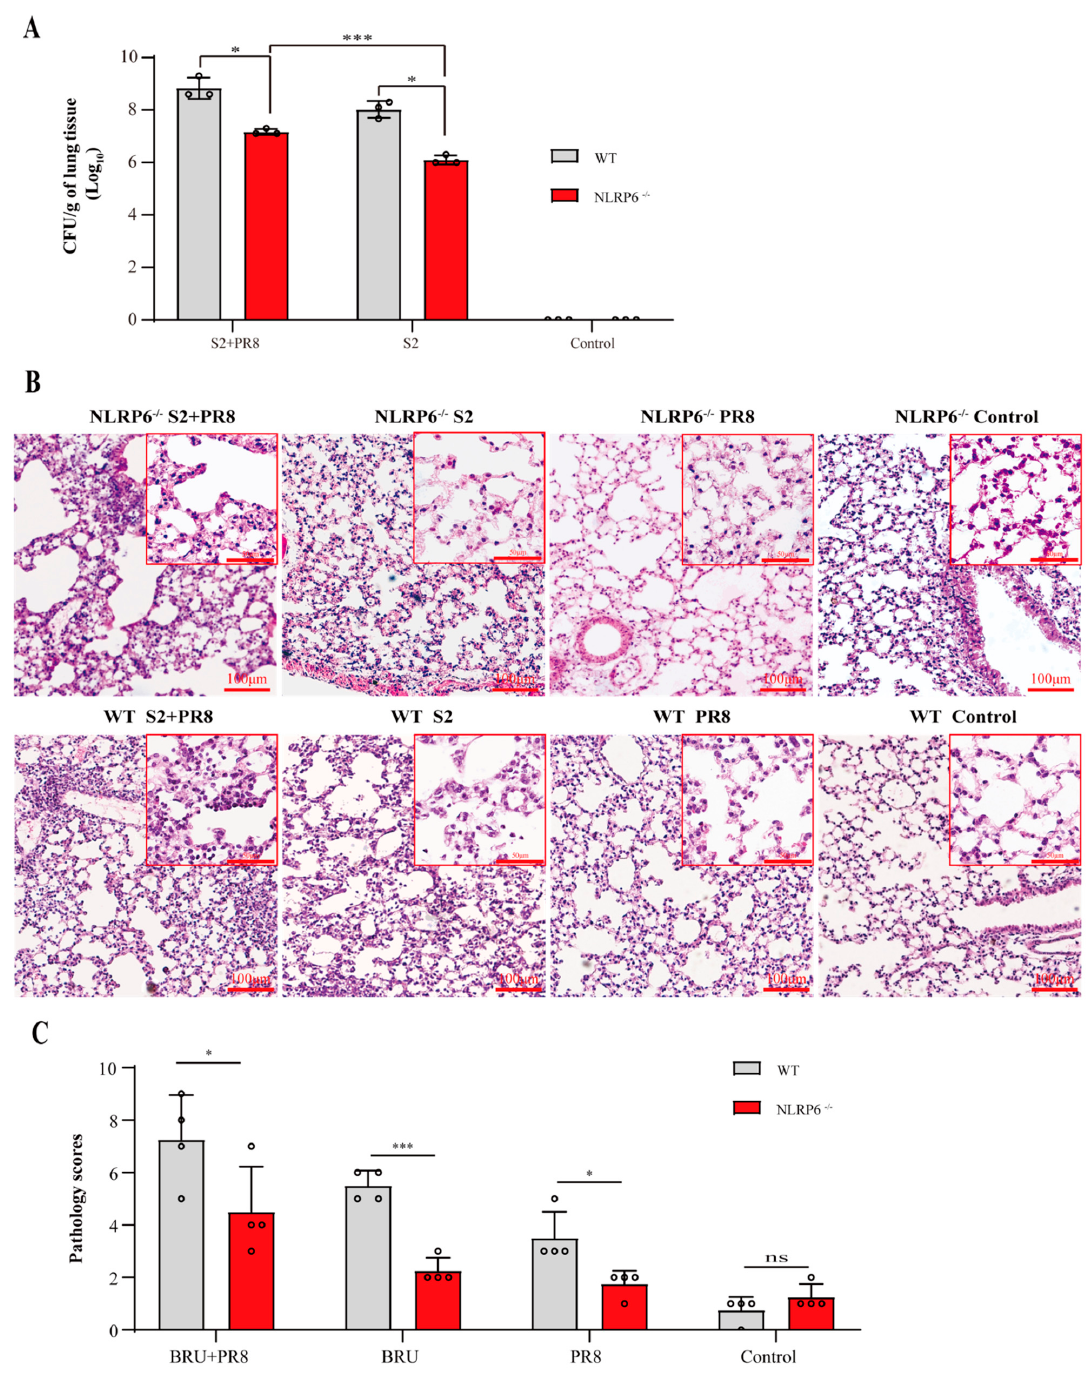
Figure 3. NLRP6 − / − mice were more resistant to coinfection than WT mice. ( A ) The Brucella count (log 10 ) of NLRP6 − / − was more significantly decreased than that of WT mice. Two-tailed unpaired Student’s t-test was used to compare two groups. Results expressed as mean ± standard; * p < 0.05; *** p < 0.001. ( B ) The levels of inflammation and tissue damage in NLRP6-/-mice were milder than those in WT mice. Pathological sections of lung tissue were observed under a light microscope 3 days post infection. (With magnification of 10 × and 40 ×). ( C ) Graph showing pathology score of the lung tissues after the infection. Two-tailed unpaired Student’s t -test was used to compare two groups. Results expressed as mean ± standard; * p < 0.05; *** p <